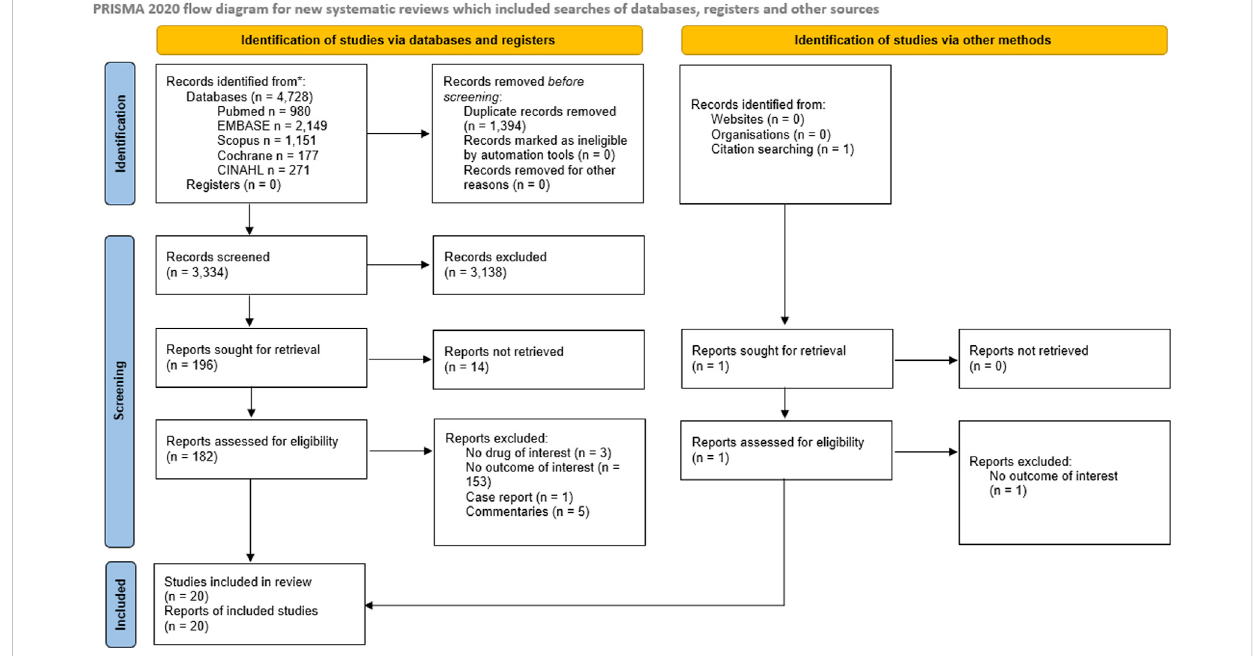
FIGURE 1 PRISMA 2020 fl ow diagram depicting the fl ow of information through the different phases of the Systematic